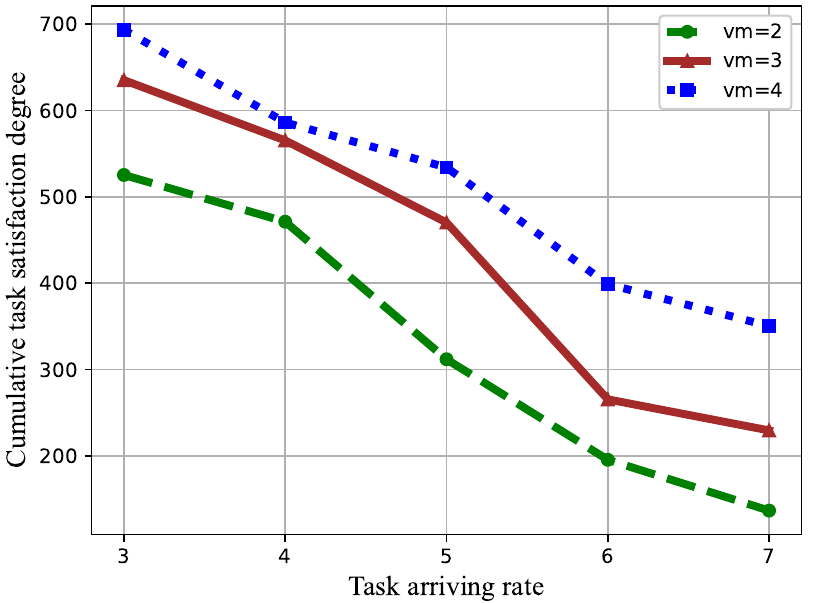
Figure 6. Cumulative task satisfaction degree versus task arriving rate and the number of